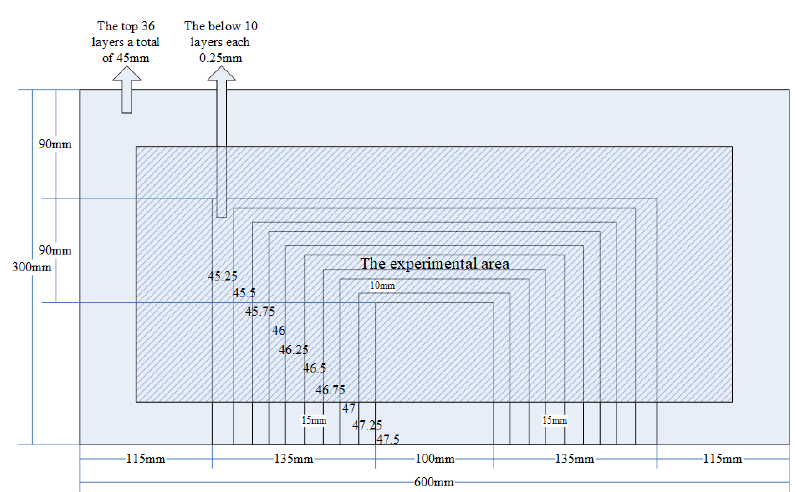
Figure 3. Change of ply thickness of composite laminate on the tank